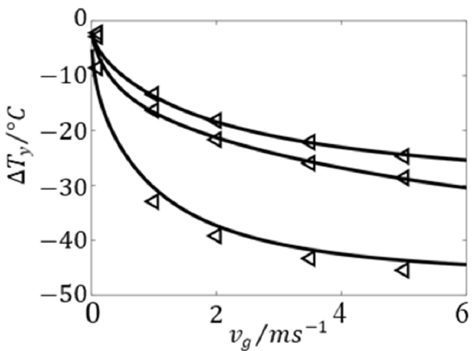
Figure 15. Maximum temperature difference on a wire as function of inflow gas velocity and for different geometries. Comparison between analytical solutions using Equation (20) (solid lines) and values from CFD analysis (triangles).